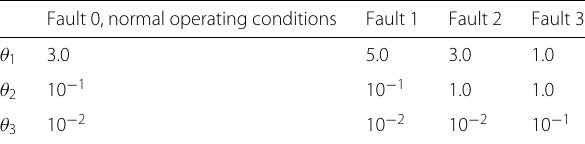
faulty conditions of oscillator (46) in the example 3